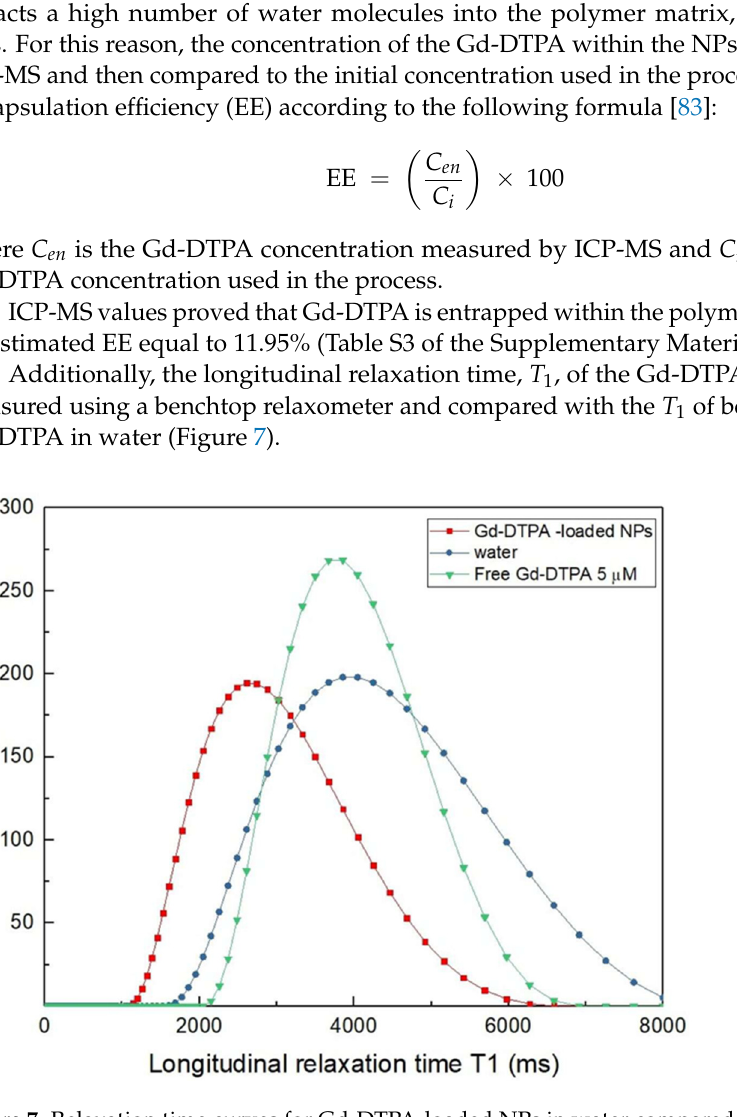
Figure 7. Relaxation time curves for Gd-DTPA-loaded NPs in water compared to free water and to the corresponding free Gd-DTPA in water.